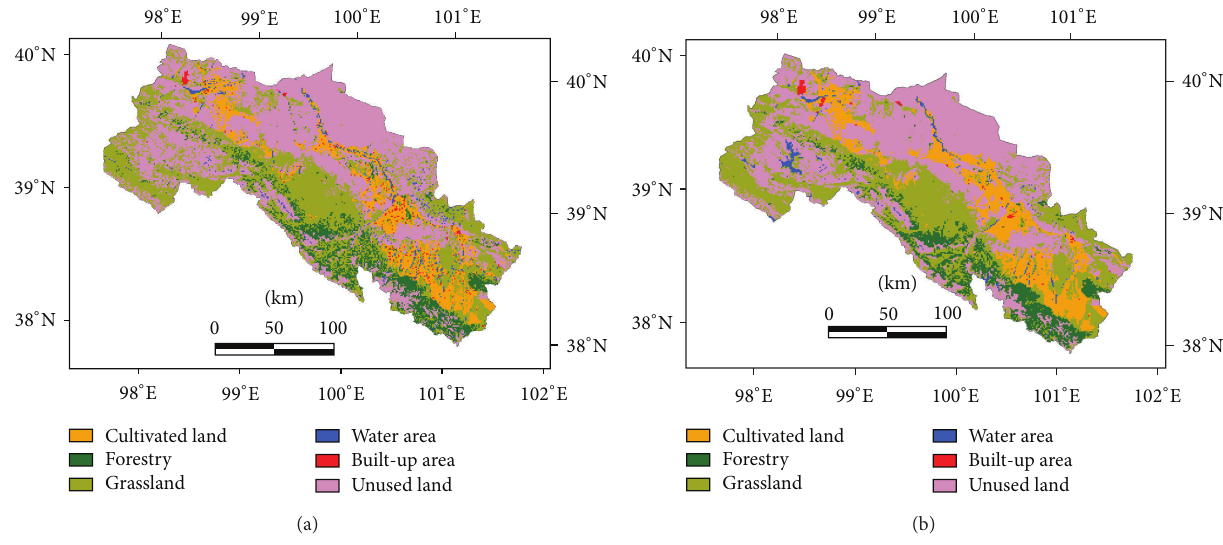
Figure 2: (a) Land use patterns of middle reaches of the HRB in 1988 and (b) land use patterns of middle reaches of the HRB in 2008.